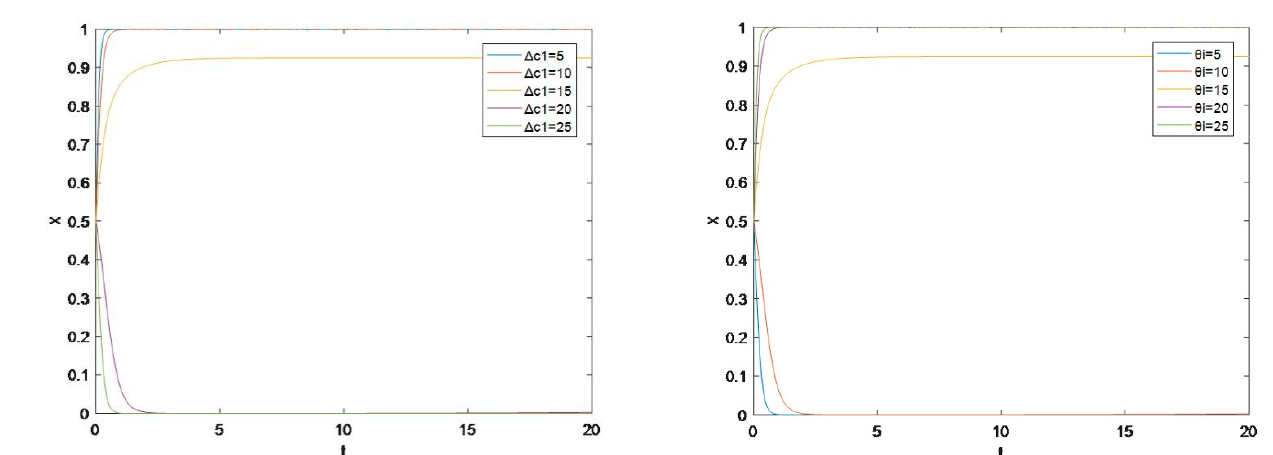
( a ) The impact of additional audit costs on central government strategies ( b ) The impact of long-term benefits on central government strategies Figure 13. The impact of additional audit costs and long-term benefits on central government strategies.